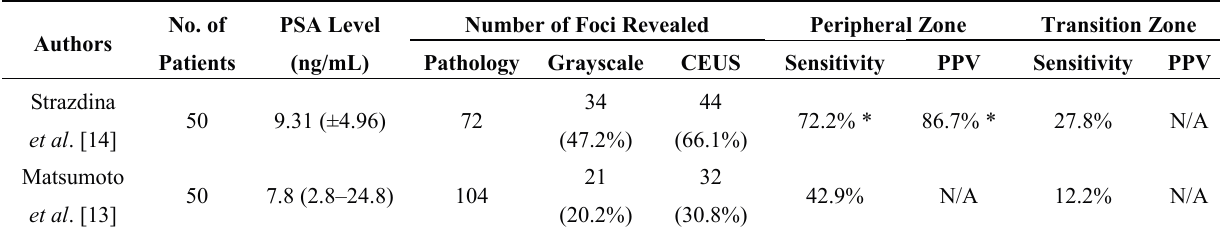
Figure 3. Patient with a PSA level of 13.8 ng/mL. CEUS showed an unenhanced nodule in the PZ of the left lobe. Biopsies of the corresponding lesion resulted in adenocarcinoma with Gleason score of 4 + 3. ( a ) Gray scale, ( b ) CEUS. Table 1. CEUS studies of prostate cancer (whole prostate